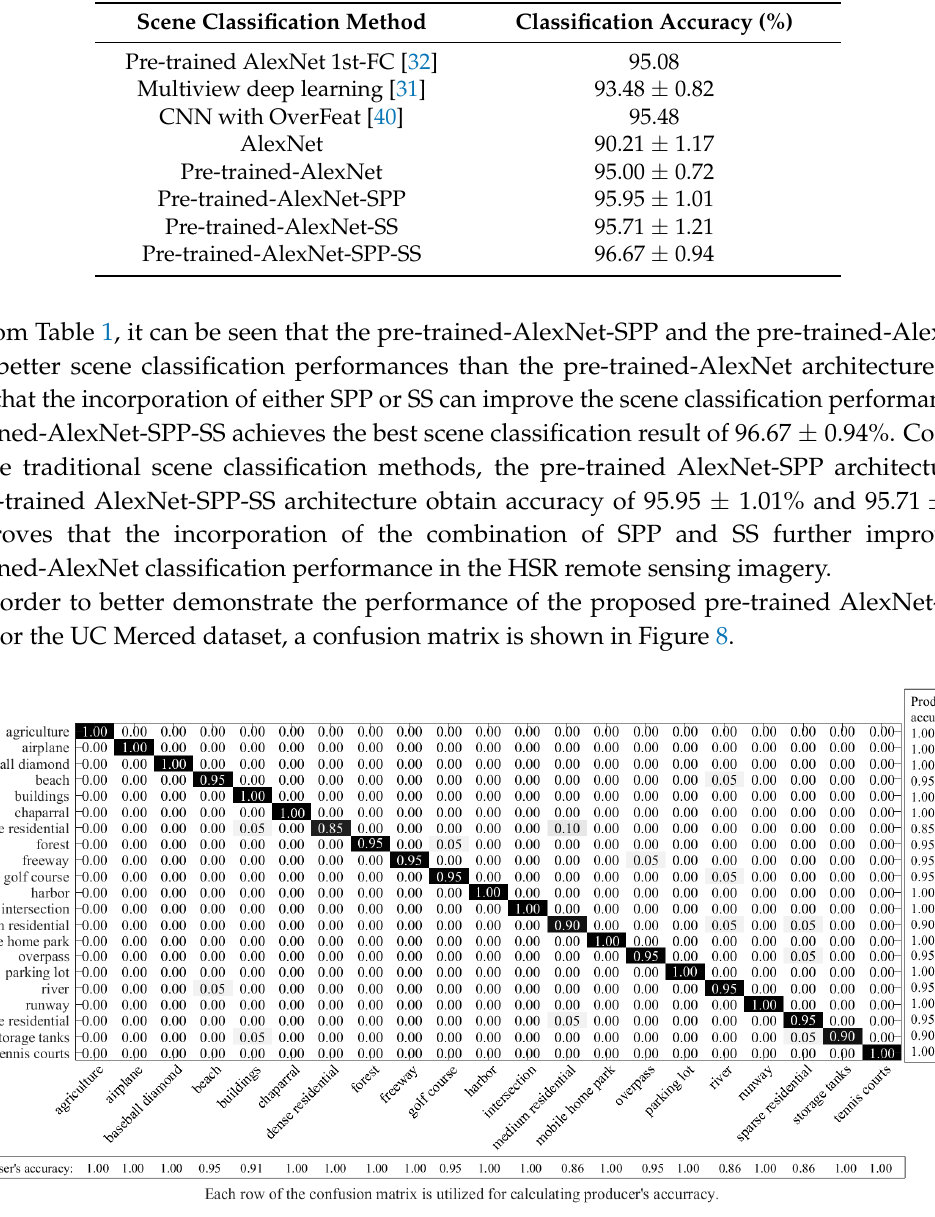
Figure 8. Confusion matrix for the pre-trained AlexNet-SPP-SS model with the UC Merced dataset.